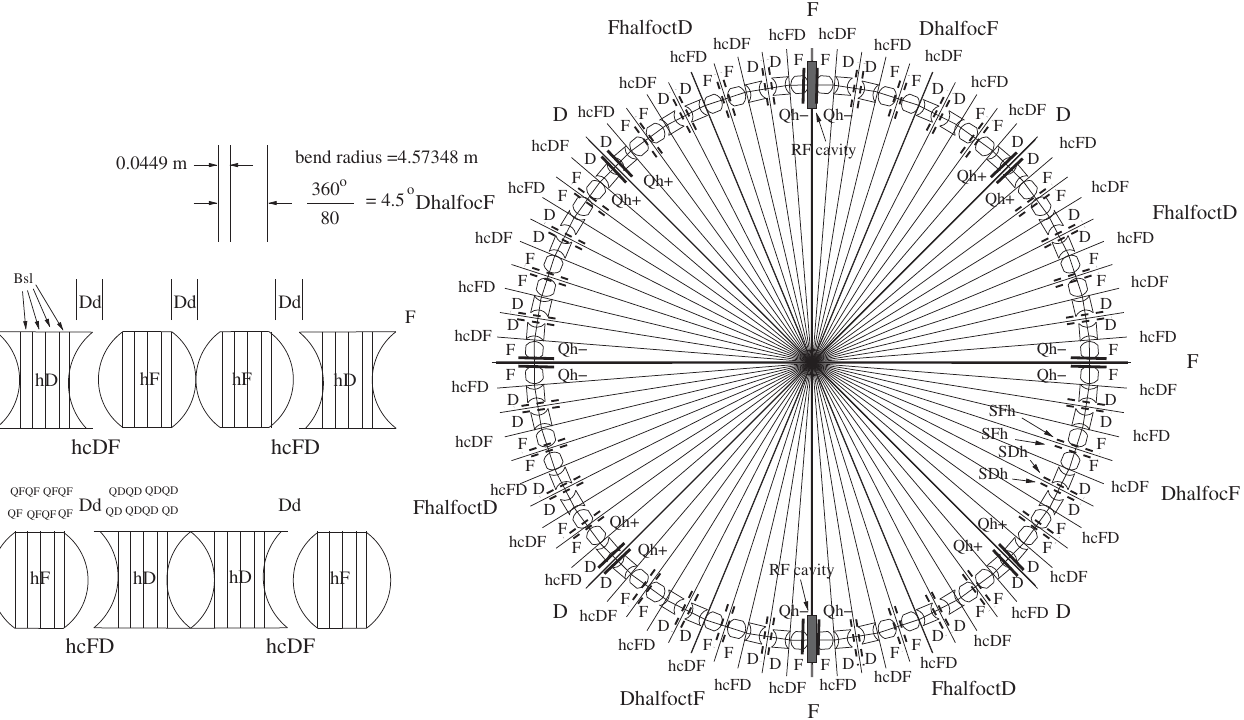
FIG. 1. The 1955 AGS analog lattice as reverse engineered from available documentation — mainly the 1953 proposal letter from BNL Director Haworth to AEC Director of Research Johnson. Individual “ lenses ” (as they were referred to in the original documentation; in modern terminology they would be referred to as “ combined function bends ” ) are shown on the left; vertical lines indicate locations of thin quadrupoles present in the lattice description to represent the focusing effect of the electric lens elements. Elements are identified by ad hoc labels assigned in the reconstruction. They are not obtained from the original lattice design, but are needed for modern day lattice description files. Lattice description files are available (for example from the authors) in various formats: E_AGS_Analogue2.xml gives the pristine design with all parameters in algebraic (or function of algebraic) form. E_AGS_Analogue2.adxf is the same, but with all parameter values, though ideal, converted to numerical values. E_AGS_Analogue2.sxf contains the fully instantiated lattice description (with parameters from otherwise identical elements allowed to be individualized). Most UAL lattice files are available in all these